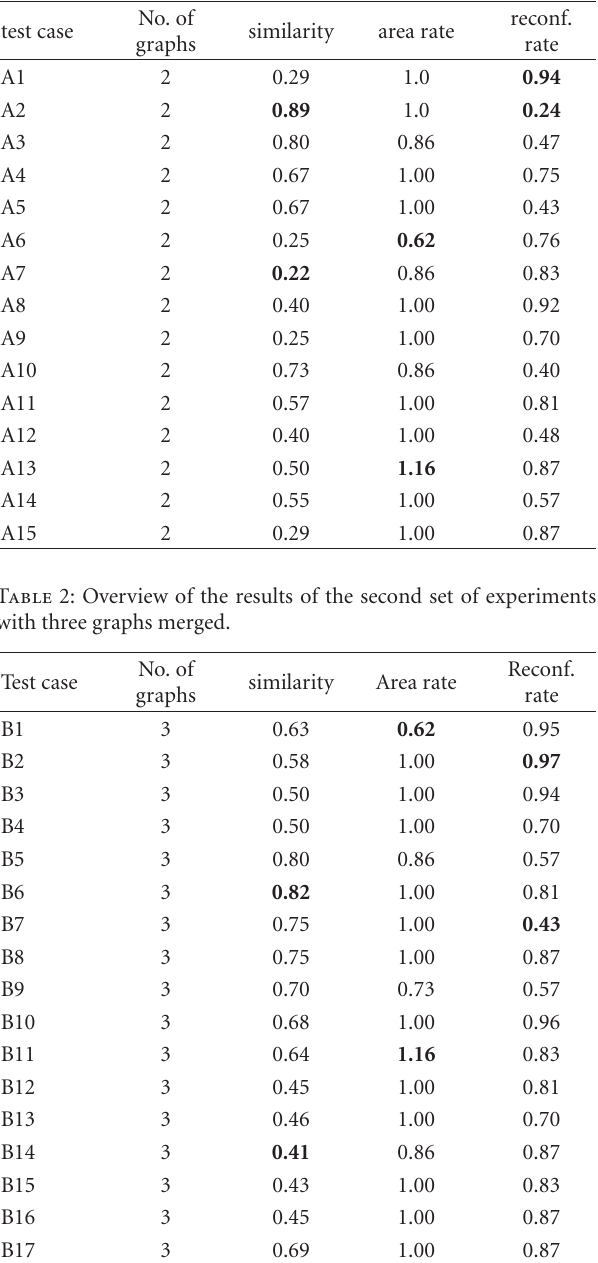
Table 1: Overview of the results of the first set of experiments with two graphs merged.